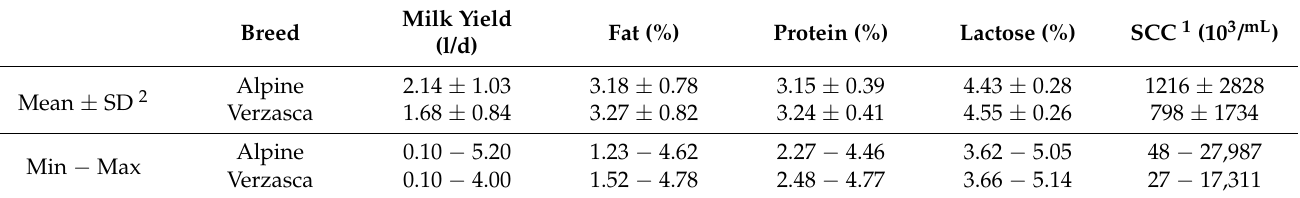
Table 3. Descriptive statistics for milk parameters in Alpine and Nera Verzasca goats. Milk Yield Fat (%) Protein (%) Lactose (%) SCC 1 (10 3 / mL ) Breed (l/d) Alpine 2.14 ± Mean ± SD 2